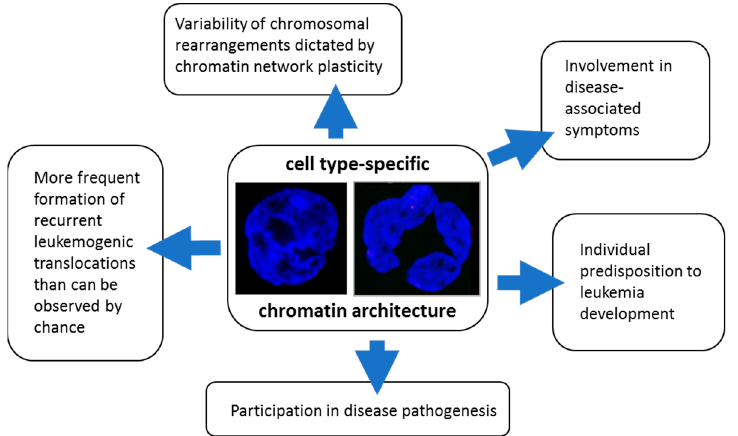
Figure 16. Multifaceted roles of the architecture of chromatin network in leukemia development and pathogenesis.